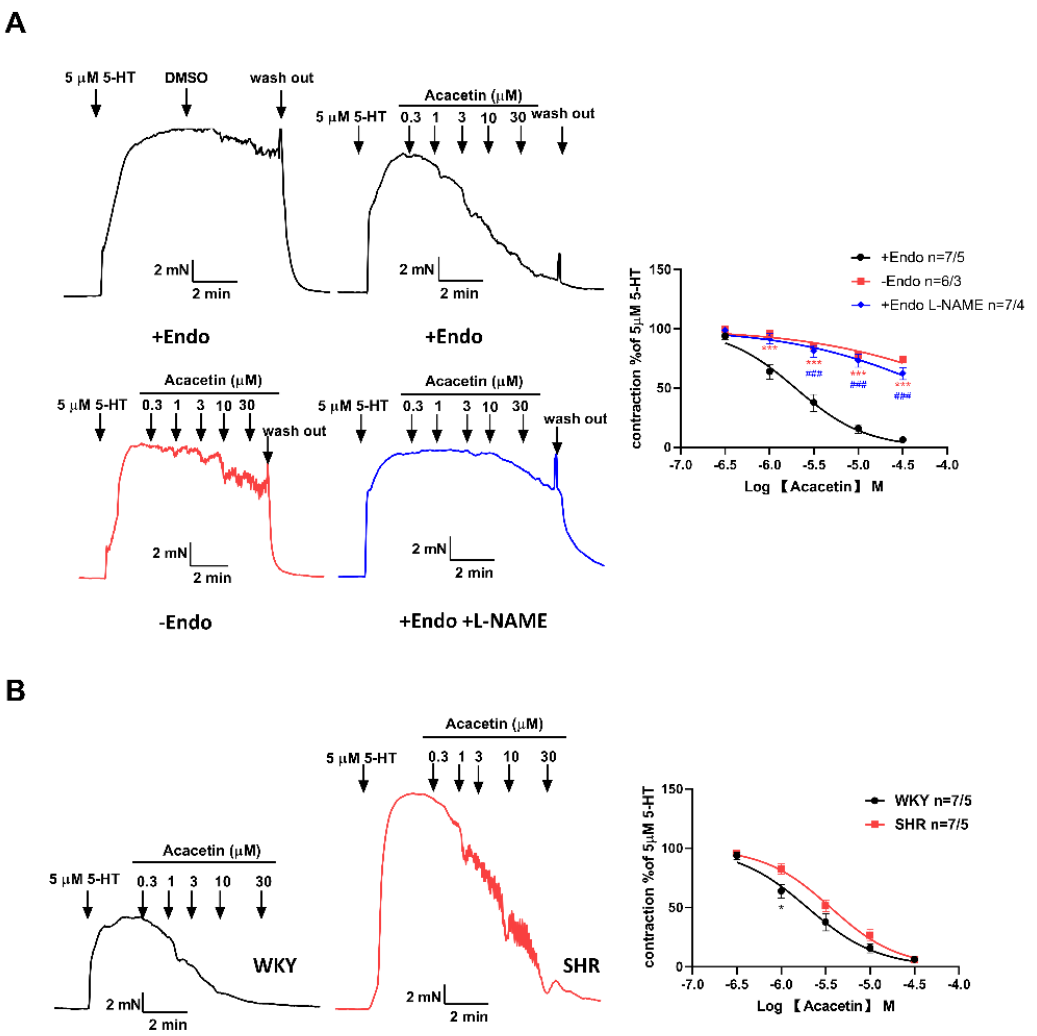
Figure 3. Acacetin mediated endothelium-dependent vasodilation by activation of eNOS. ( A ) Representative traces and fitting curves showed the vasorelaxation responses of acacetin in endothelium-intact (+Endo) and endothelium-denuded (–Endo) arteries. Blocking eNOS activity with L-NAME greatly inhibited acacetin mediated vasodilation (### p < 0.001, +Endo L-NAME group vs. +Endo group; *** p < 0.001 – Endo group vs. +Endo group; n = 6 – 7/3 – 5), and DMSO was vehicle control. ( B ) Representative traces and fitting curves showed the vasorelaxation responses of acacetin in endothelium-intact arteries from SHR and WKY rats (* p < 0.05, SHR group vs. WKY group, n =